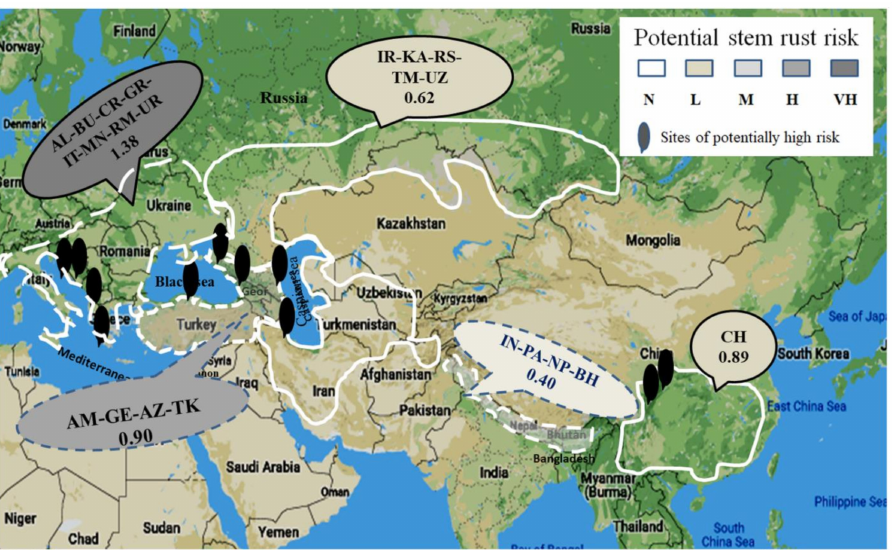
Figure 5. Areas of potential infection risks for the stem rust pathogen ( Puccinia graminis f. sp. tritici ) in Asia, including China, hilly regions of Indo–Pak–Nepal–Bhutan (IN-PA-NP-BH), Central Asia (IR-KA-RS-TM-UZ), and West Asia surrounding Black Sea and Caspian Sea (AM-GE-AZ-TK). AM = Armenia, AZ = Azerbaijan, BH = Bhutan, CH = China, IN = India, IR = Iran, KA = Kazakhstan, NP = Nepal, PA = Pakistan, RS = Russia, TM = Turkmenistan, and UZ =